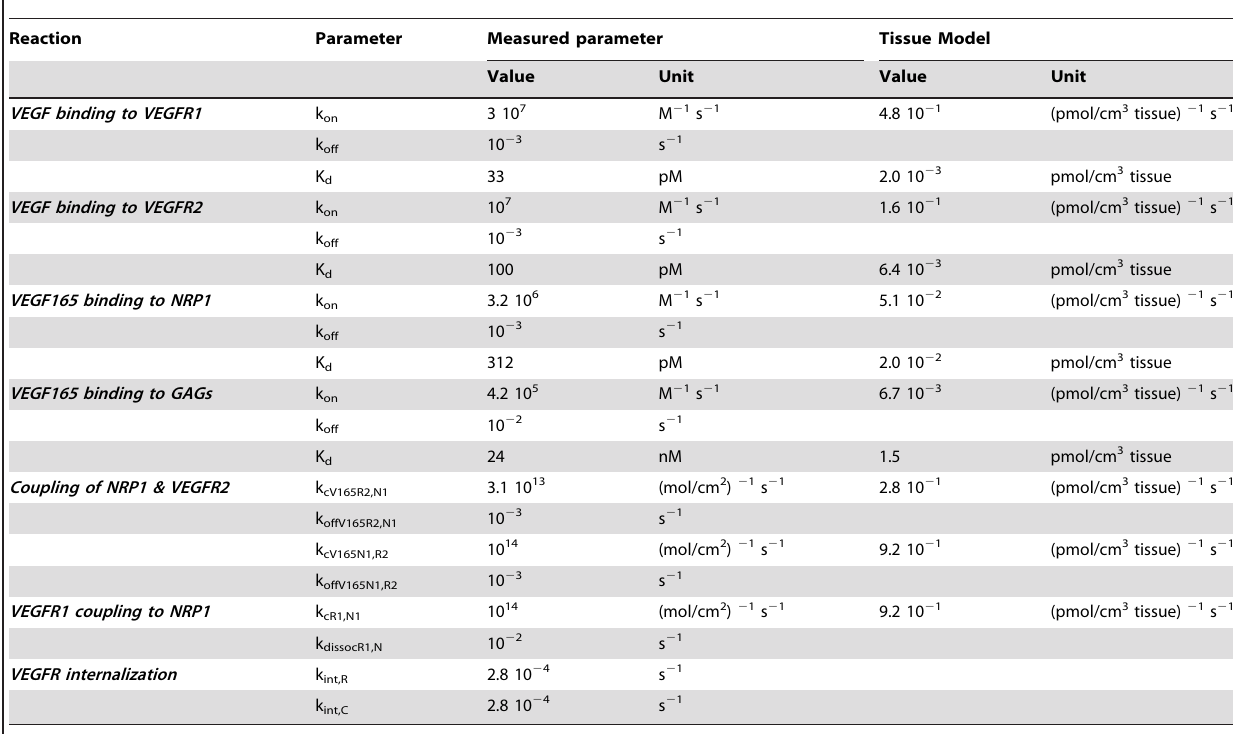
Table 2. Kinetic parameters of VEGF in the tissue (human vastus lateralis muscle).